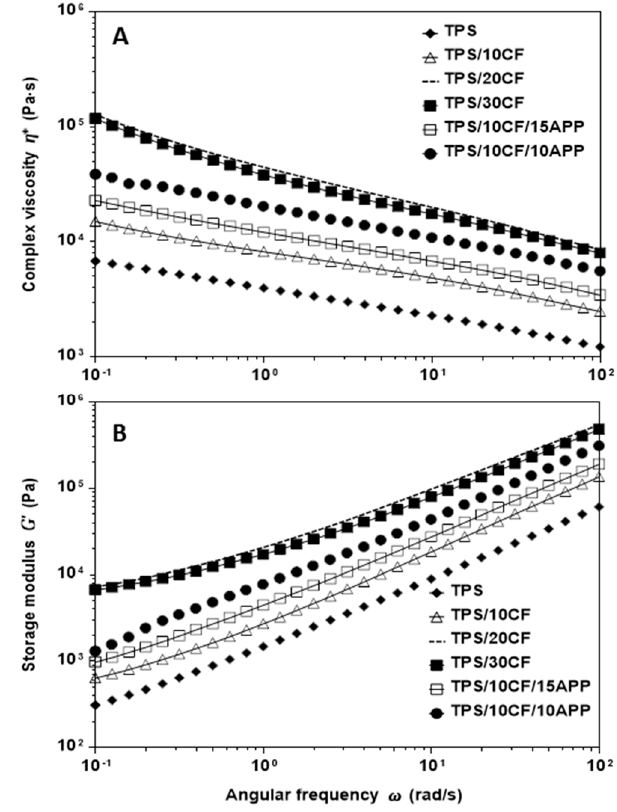
Figure 8. Complex viscosity ( A ) and storage modulus ( B ) as a function of the oscillatory frequency of TPS, TPS/CF and TPS/CF/APP composites with varied content.